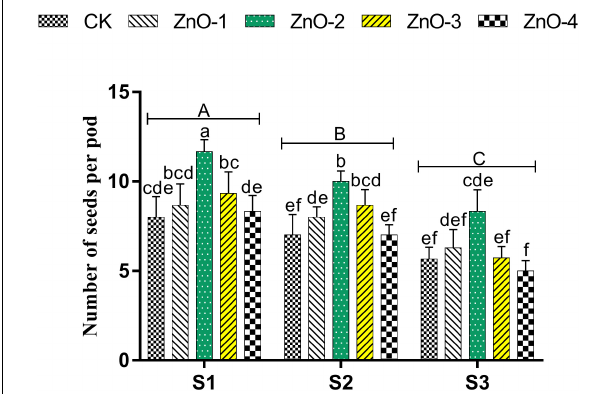
FIGURE 6 | Effect of foliar application of nano-ZnO on number of seeds per pod in Vigna radiata under sowing time generated heat stress.